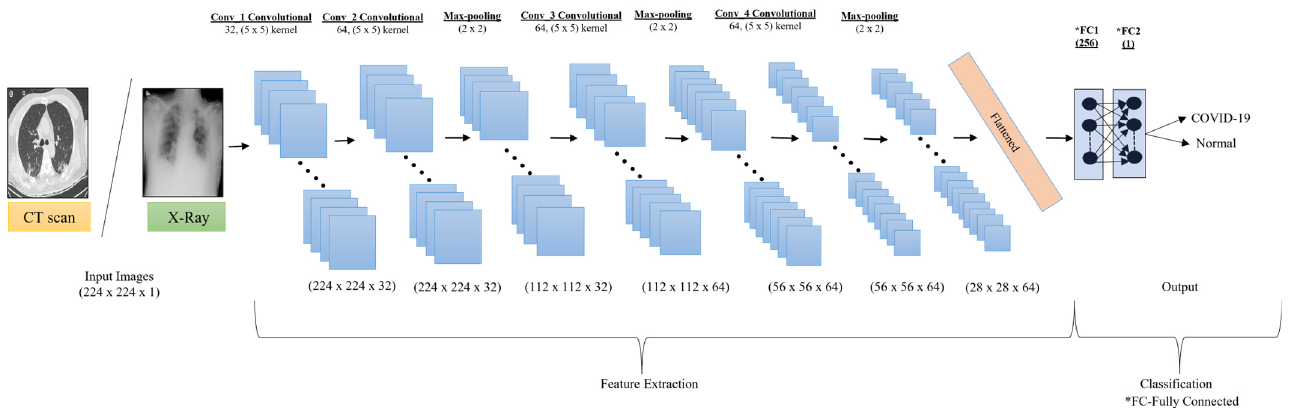
Figure 5. Proposed SCovNet architecture for COVID-19 detection.